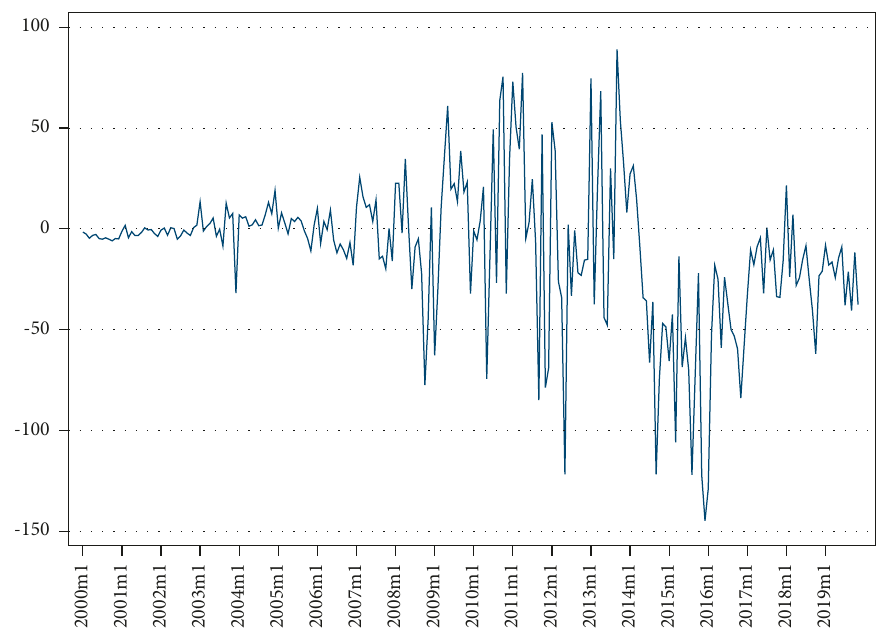
Figure 1: The hot money flows in China (billion USD). Source :Authors’ calculations.